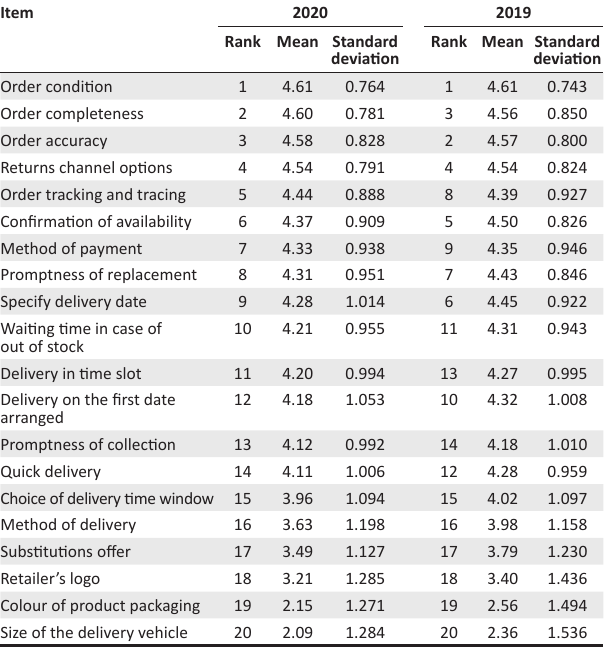
TABLE 4: Mean ranking of service quality variables.